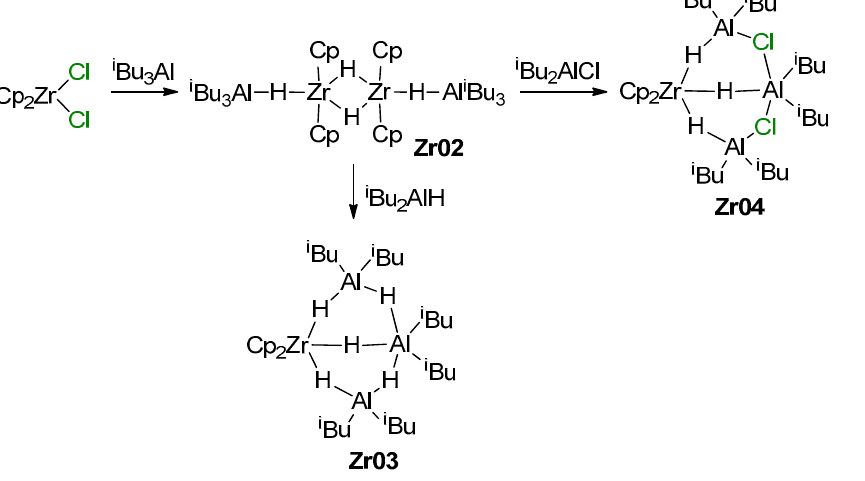
Figure 12. Molecular structure of one of the crystallographic independent molecules of Cp 2 ZrMeCl … AlMe 3 ( Zr01 ′ ). Reprinted with permission from [127]. Copyright (1995) American Chemical Society. It is obvious that the reactions of L 2 ZrCl 2 with i Bu 2 AlH or i Bu 3 Al may result in the formation of Zr–Al hydrides, which is accompanied by isobutylene elimination in the latter case [128]. The rate and equilibria of the reaction with i Bu 3 Al also strongly depend on the nature of the η 5 -ligand fragment L 2 ; for instance, Ph 2 C(Cp)(Flu) forms a mono-alkyl complex Ph 2 C(Cp)(Flu)Zr( i Bu)Cl even with a 50-fold excess of i Bu 3 Al, whereas Cp 2 ZrCl 2 reacts with an excess of i Bu 3 Al with the formation of [Cp 2 ZrH 2 · Al i Bu 3 ] 2 ( Zr02 ) [128], and reaction with i Bu 2 AlH results in Zr03 [129] (Scheme 14). In the presence of i Bu 2 AlCl, Zr02 demonstrate similar behavior [129]. For Zr ansa -complexes, the formation of L 2 ZrCl( µ - H) 2 Al i Bu 2 species was detected.